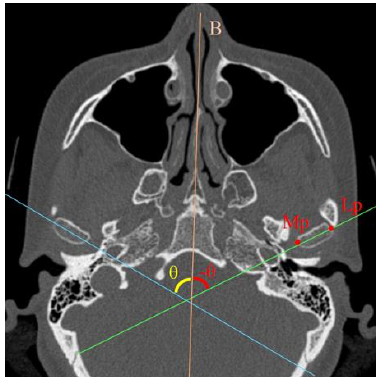
Figure 5. Landmarks, reference line, and angular measurement of condyle on an axial plane.